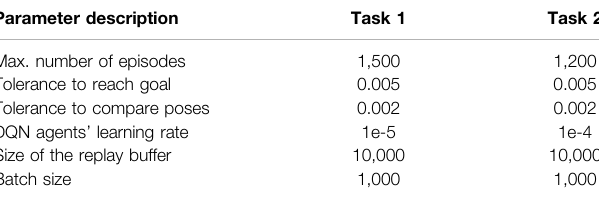
TABLE A1 | Hyper-parameters used in the DRL training